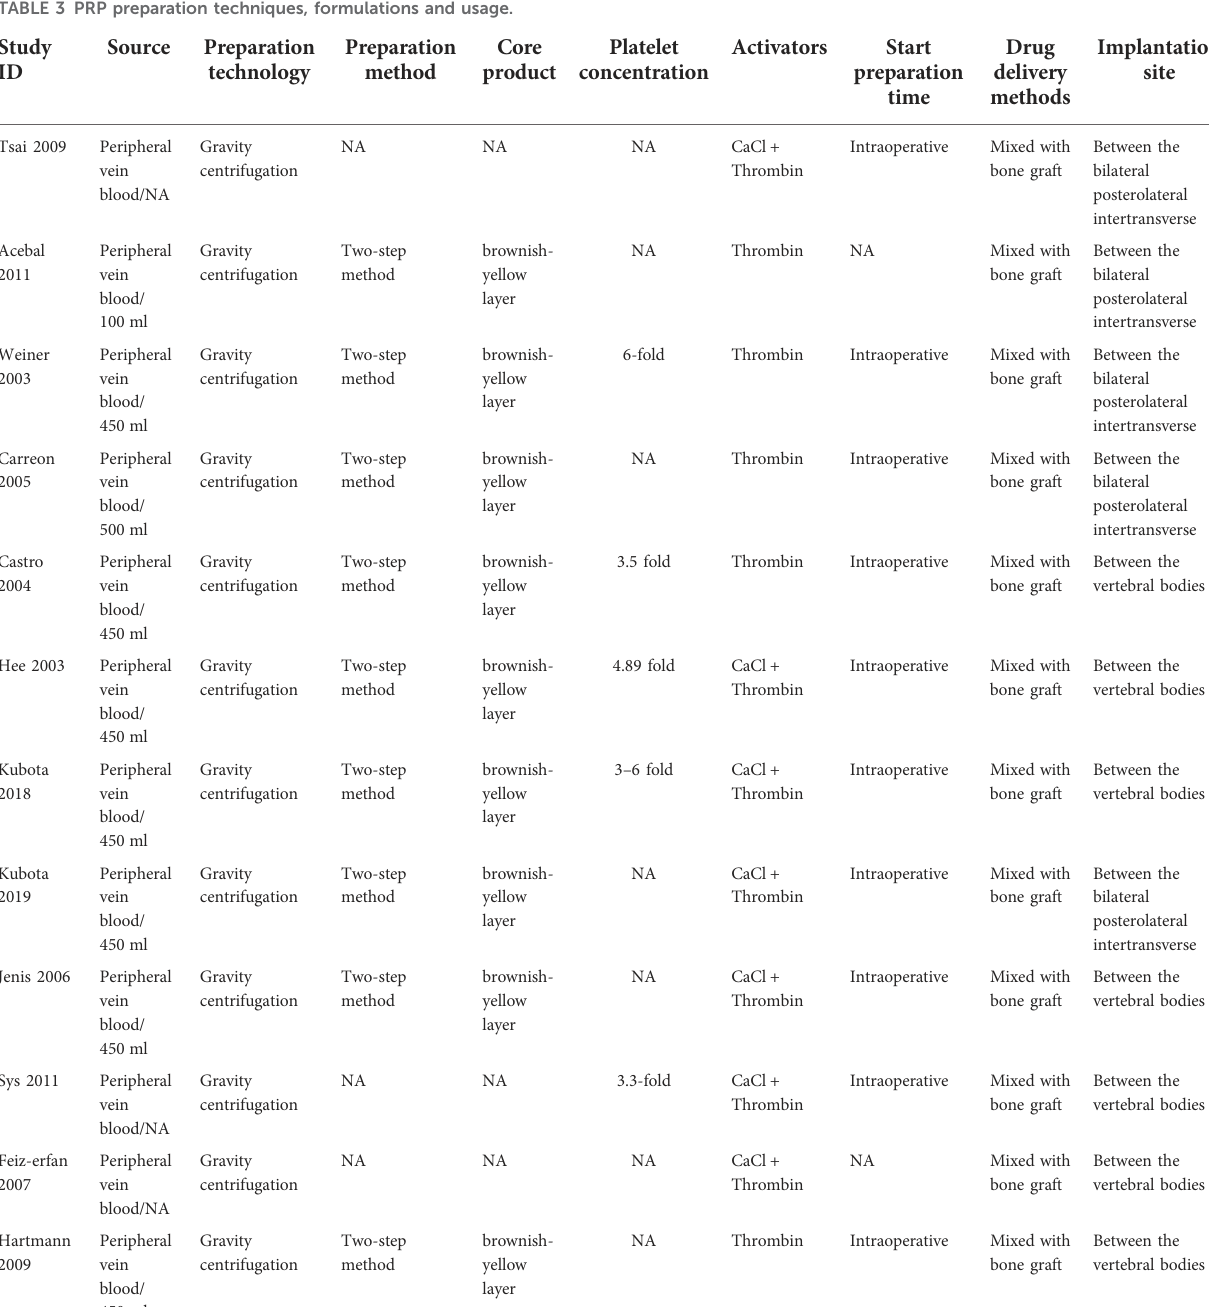
TABLE 3 PRP preparation techniques, formulations and